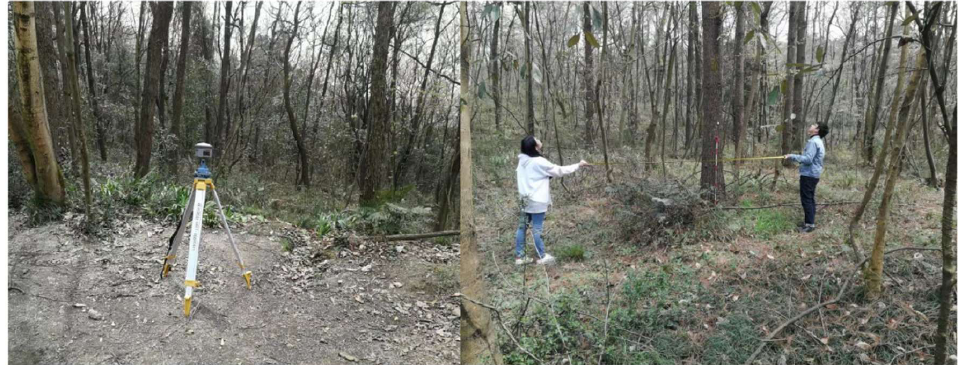
Figure 3. Data acquisition of tree structure parameters in the field experiments. Table 2. Structural characteristics of coniferous and broadleaved forest based on field forest inven- tory